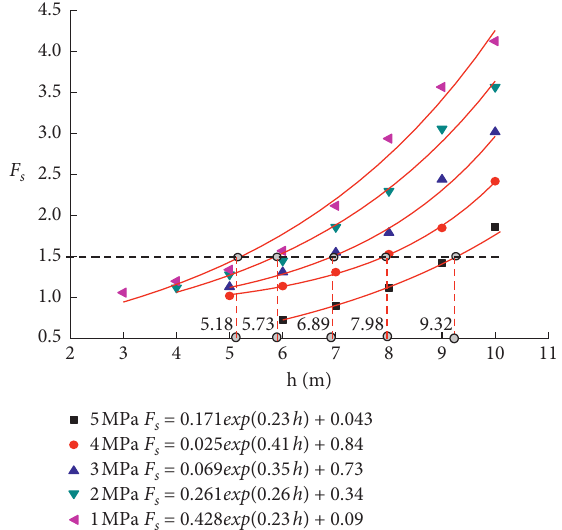
Figure 18: Variation relation curves between safe factor and calculation safety thickness of the water-proof rock